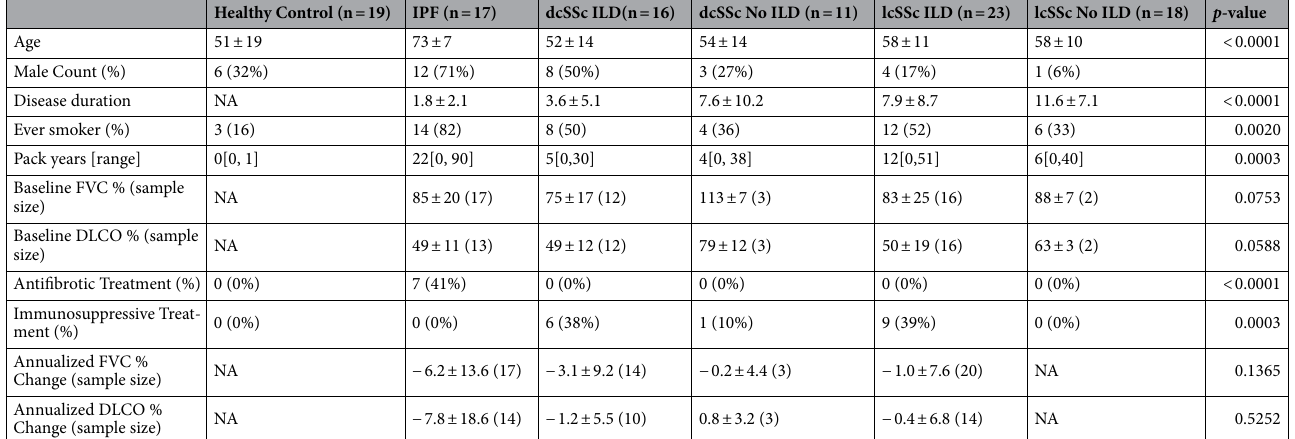
Table 1. Baseline participant characteristics. Disease duration is defined as time of ILD first seen on HRCT in IPF and time from first non-Raynaud’s phenomenon in SSc with and without ILD. Antifibrotic treatment includes nintedanib or pirfenidone. Immunosuppressive treatment includes azathioprine, cyclophosphamide, mycophenolate mofetil, or rituximab. Mean ± SD reported for continuous variables except pack years for which the mean and range is reported. Count and percentage proportion reported for dichotomous variables. The p -values computed for the continuous variables are by the nonparametric Kruskal–Wallis for no shift in location for available groups. The p -values for the categorical variables are by Fisher’s exact test.